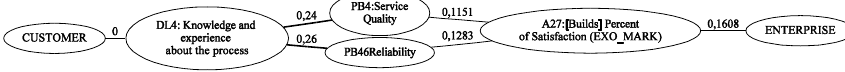
Fig. 9. Zoom on DL4 (“Knowledge and Experience about the